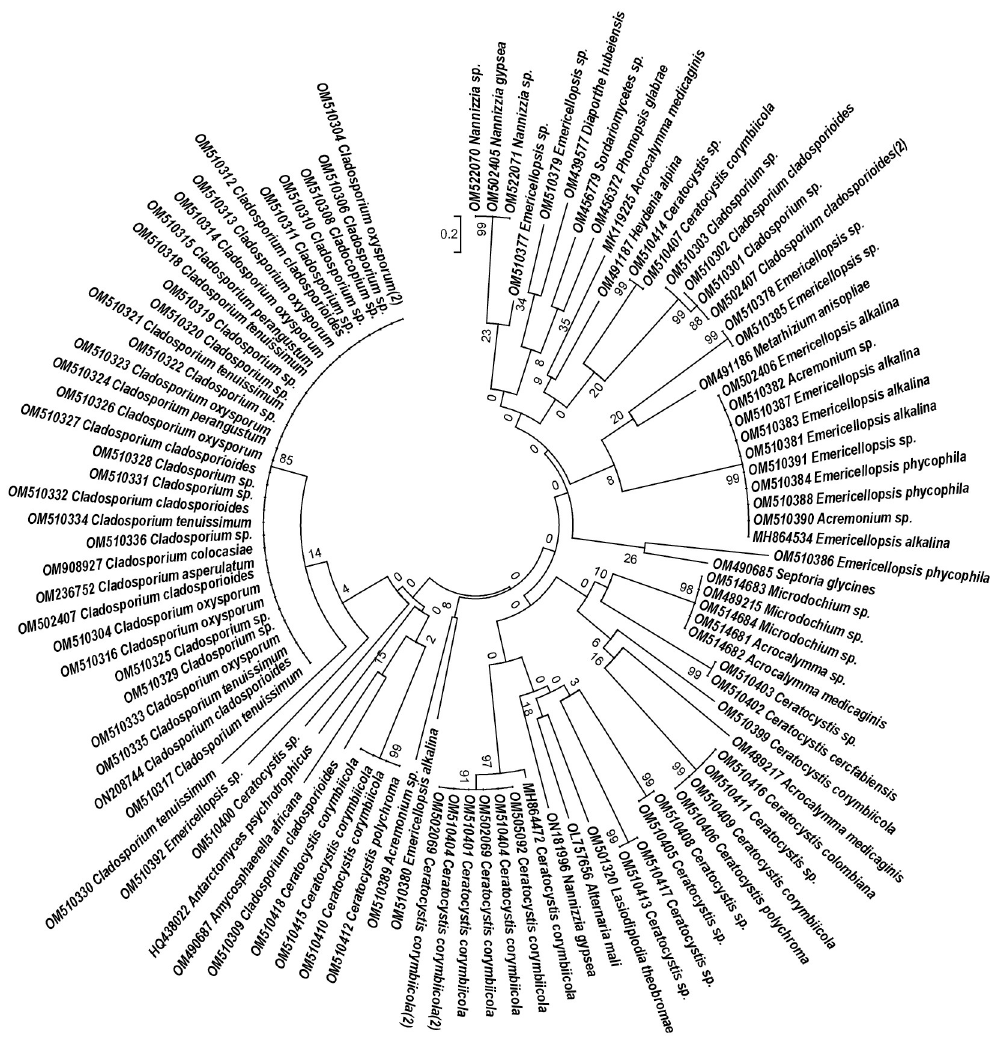
Fig 2. Phylogenetic tree of marine fungi and reference sequence accession numbers constructed by using neighbour joining method in the MEGA 5.2